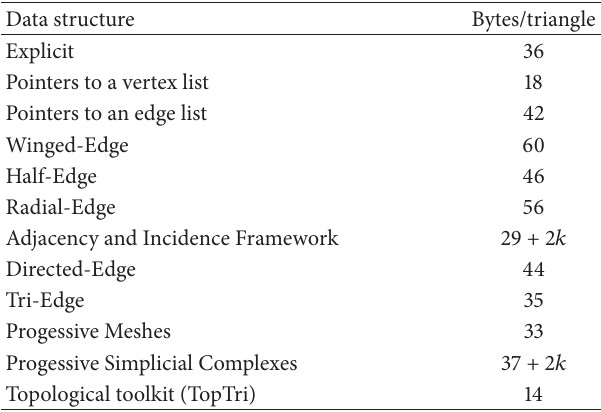
Table 3: Memory cost per triangle for the representation of geom- etry and